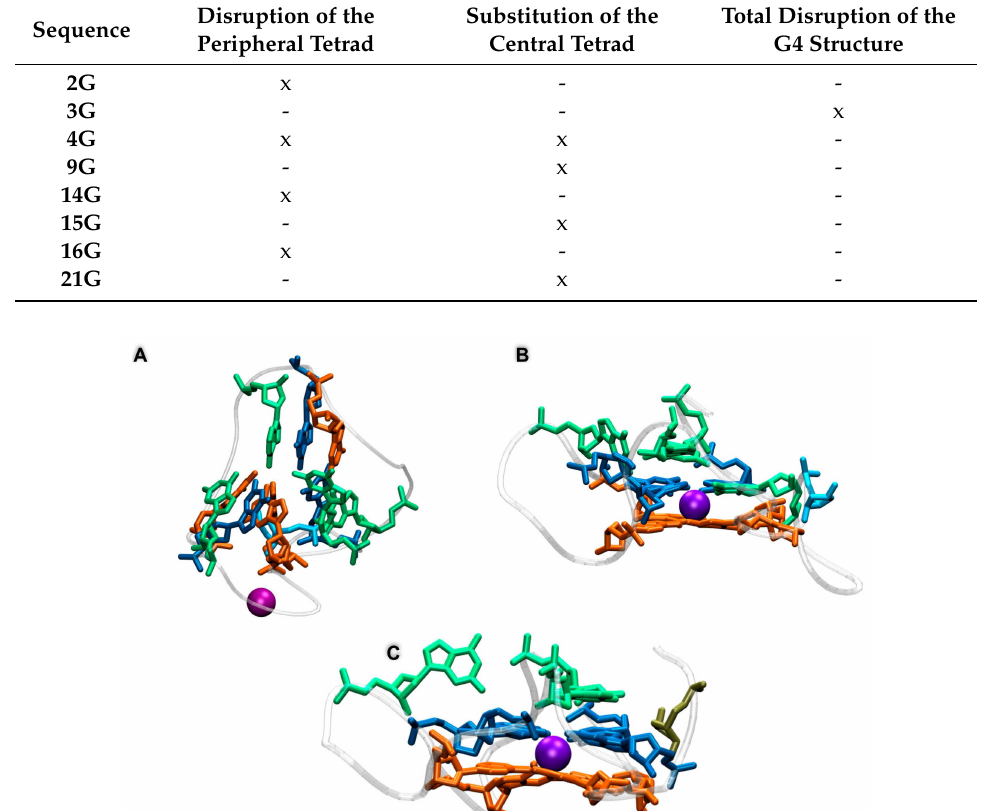
Figure 2. Representative snapshots illustrating the behavior of the di ff erent classes of G4: ( A ) total disruption of the G4 structure as experienced by 3G , ( B ) substitution of the damaged nucleobase on the central tetrad as experienced by 9G , and ( C ) disruption of the peripheral tetrad as evidenced by 2G . The representative snapshots for the other damages are given in Supplementary Informations